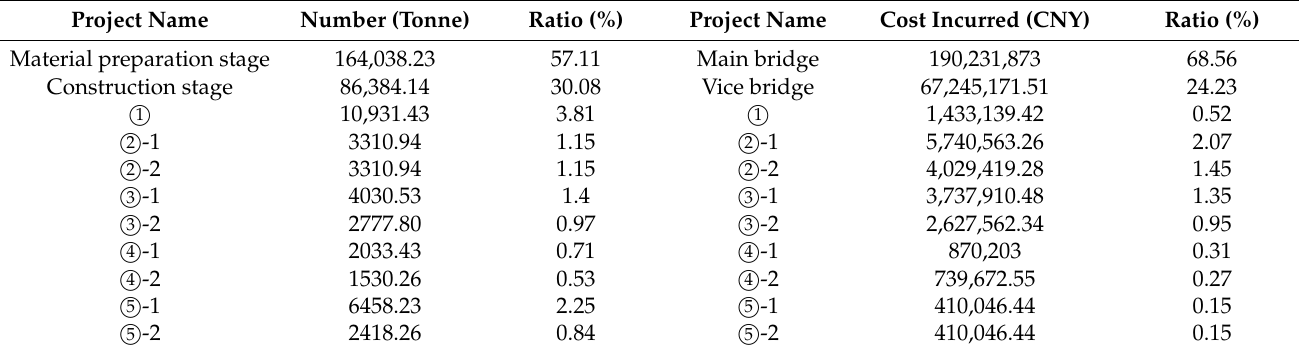
Table 3. Bridge environmental impact and economic